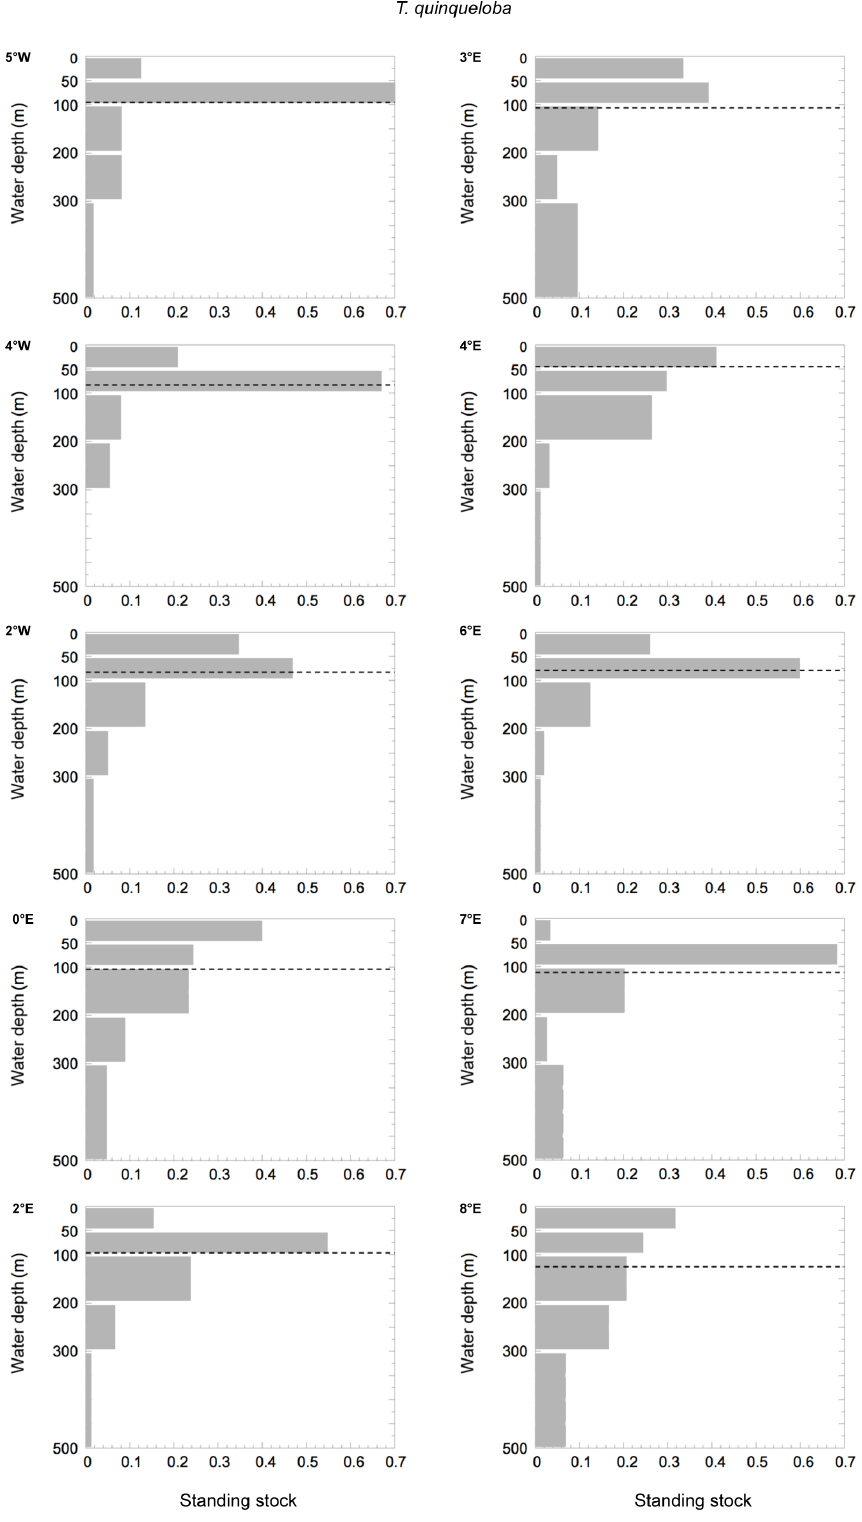
Figure 7. Standing stock of T. quinqueloba for each sampling interval. The black dashed line indicates the average depth of calcification (calculated from the standing